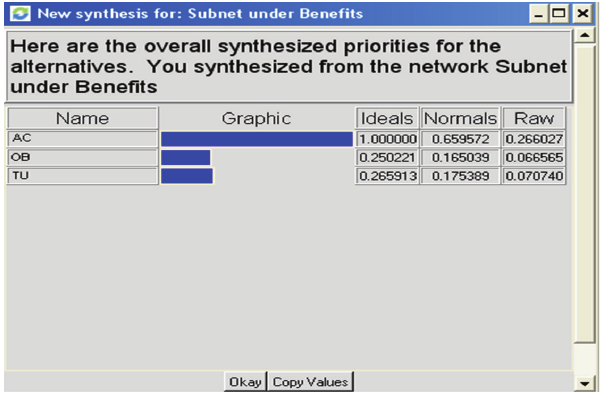
Figure 11: Priorities of the alternatives obtained by ANP method.